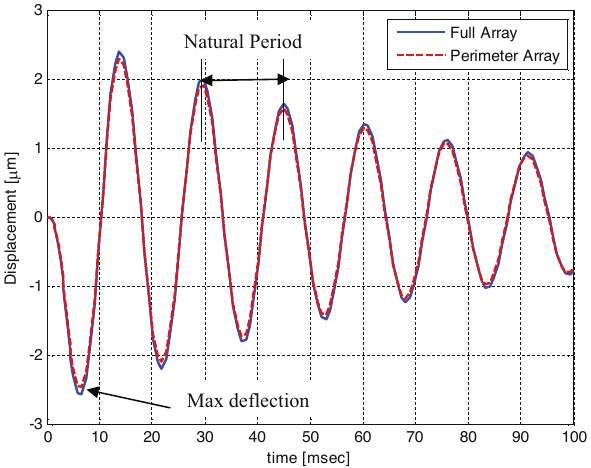
Figure 5: Time response of the out - of - plane de fl ections of the PCB in full and perimeter rray.